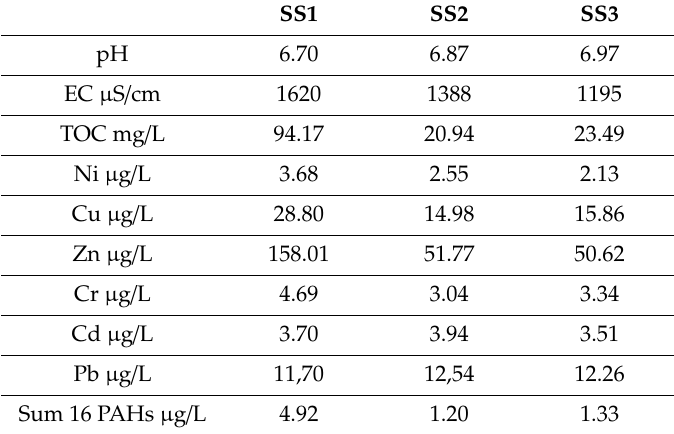
Table 3. Physico-chemical characterization of sewage sludge